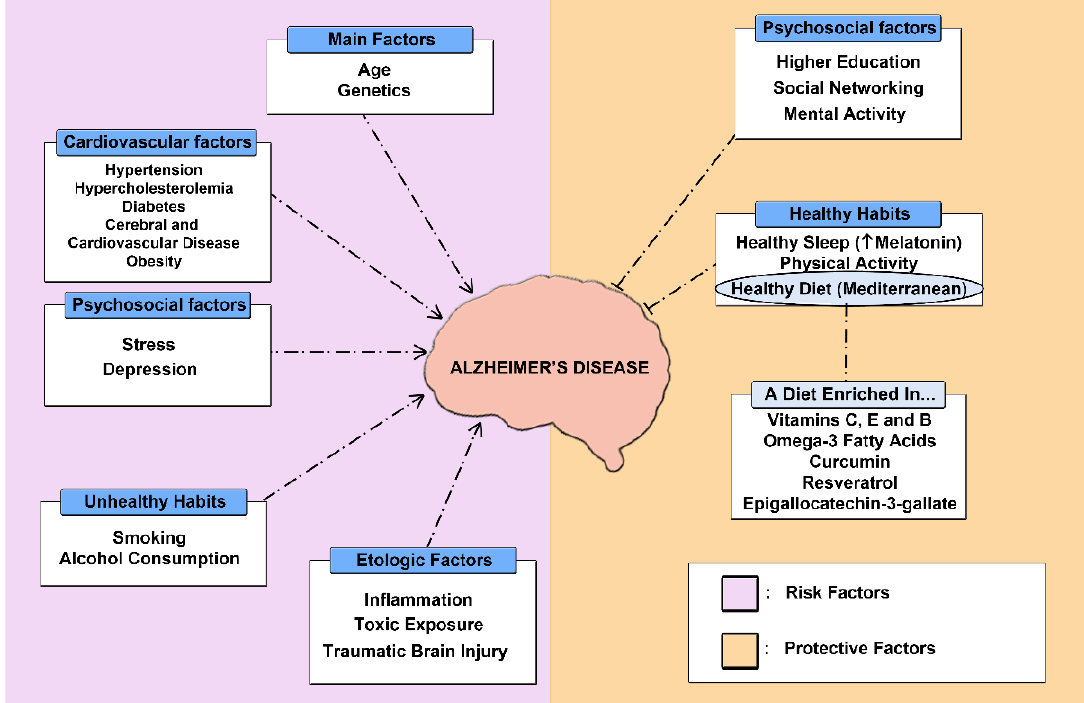
Figure 3. Diagram of protective and risk factors associated with Alzheimer’s disease.